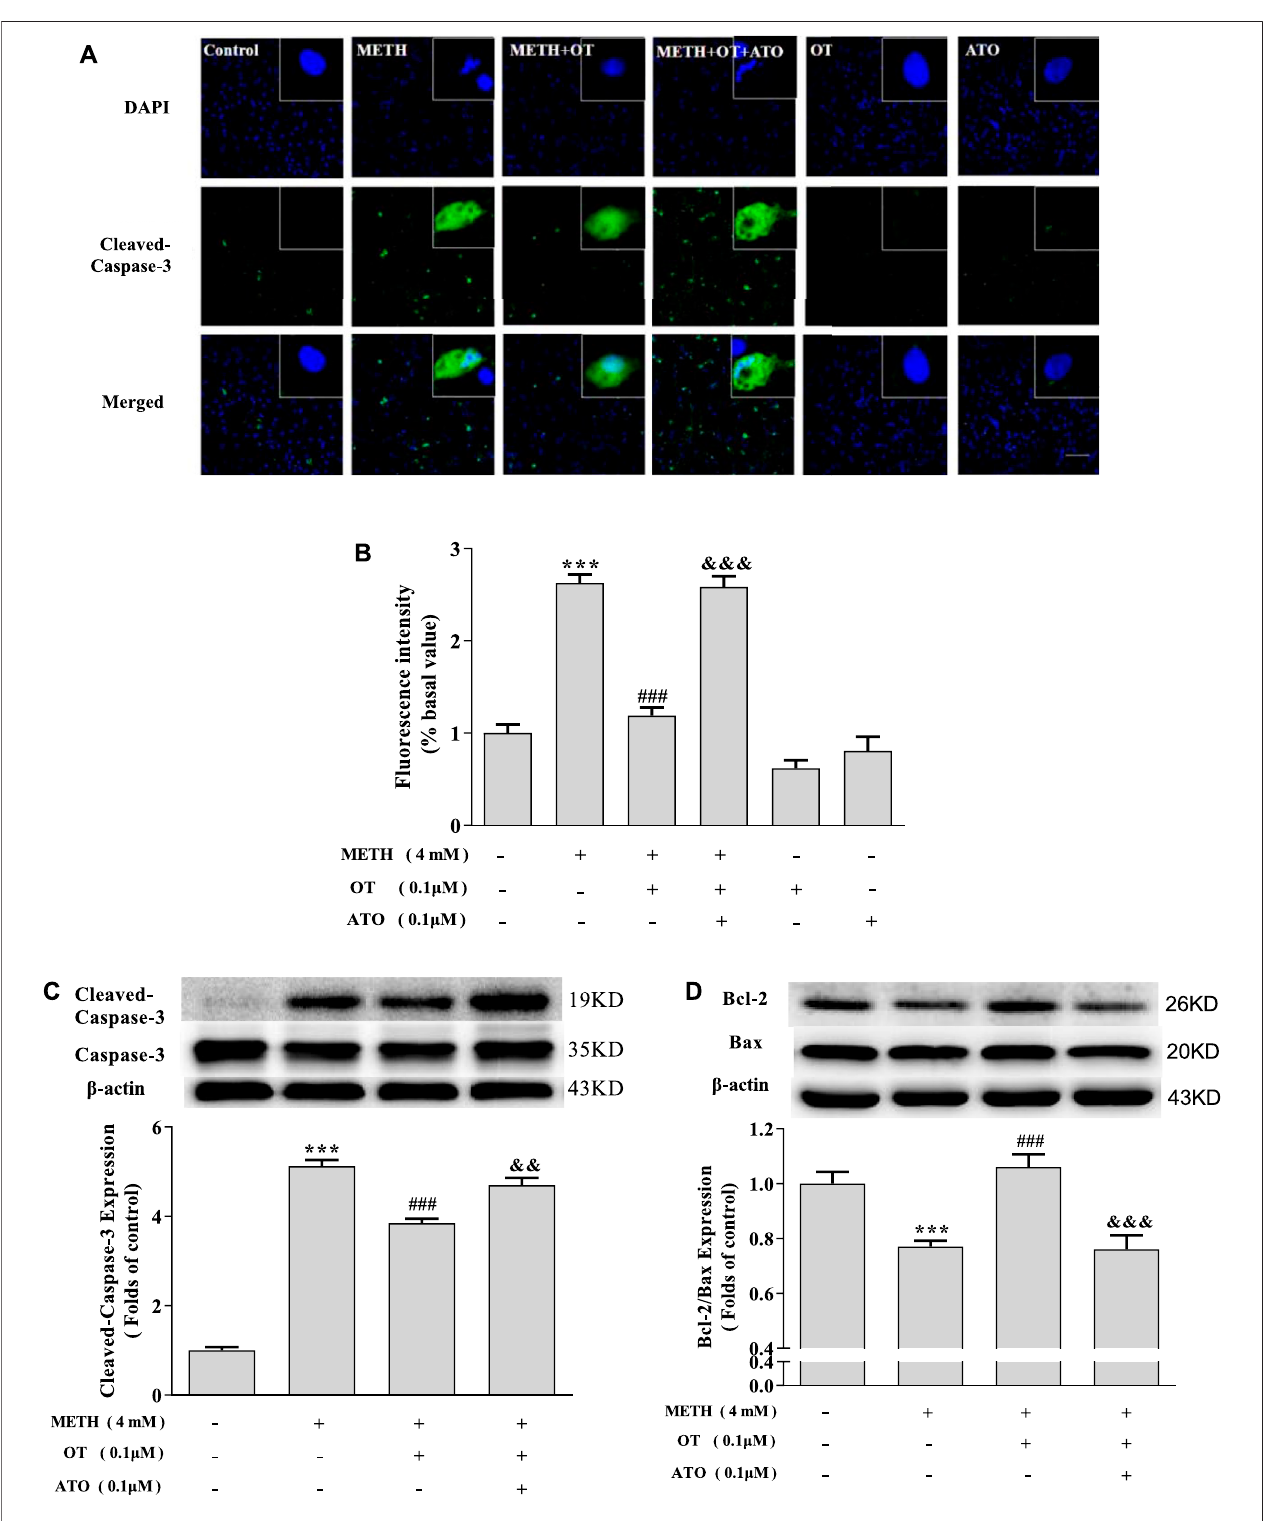
FIGURE 4 | The effect of pre-incubation ATO and OT on METH-induced changes in the expression of Cleaved-Caspase-3 and Bcl-2/Bax. (A, B) Hippocampal neurons were pre-treated with OT (0.1 μ M) and ATO (0.1 μ M) for 2 h and stimulated with METH for 24 h. The panels in the columns marked “ Merged ” are merged images of the panels in the two left columns. ( × 20 objective; Scale bar (cid:2) 50 μ m). Each image by (IOD sum)/(area sum) represent the Cleaved-caspase -3 levels. (C-D) Hippocampal neurons were pre-treated with OT (0.1 μ M) and ATO (0.1 μ M) for 2 h and stimulated with METH (4 mM) for 24 h by western blotting. The data were shown as mean ± SEM ( n (cid:2) 3). *** p < 0.001 compared with control group; ### p < 0.001 compared with METH group; && p < 0.01, &&& p < 0.001 compared with METH + OT group.